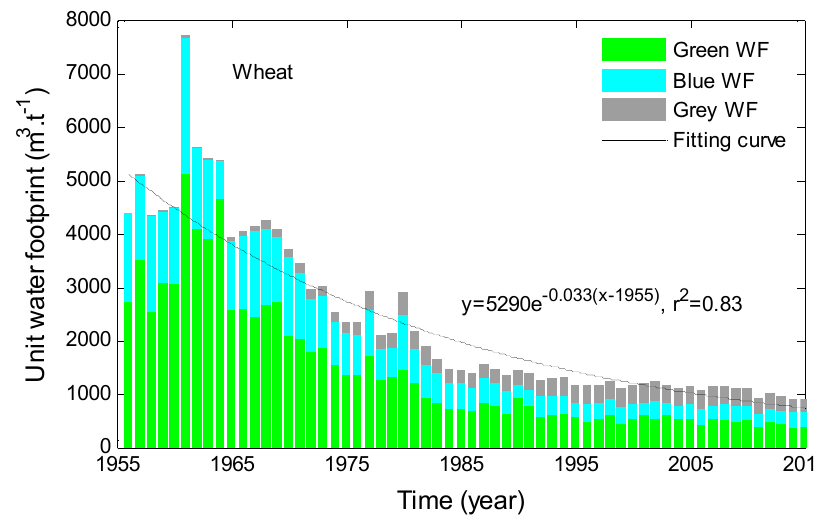
Figure 2. Unit WF and historical trend for wheat in the HRB over the period 1956–2015.